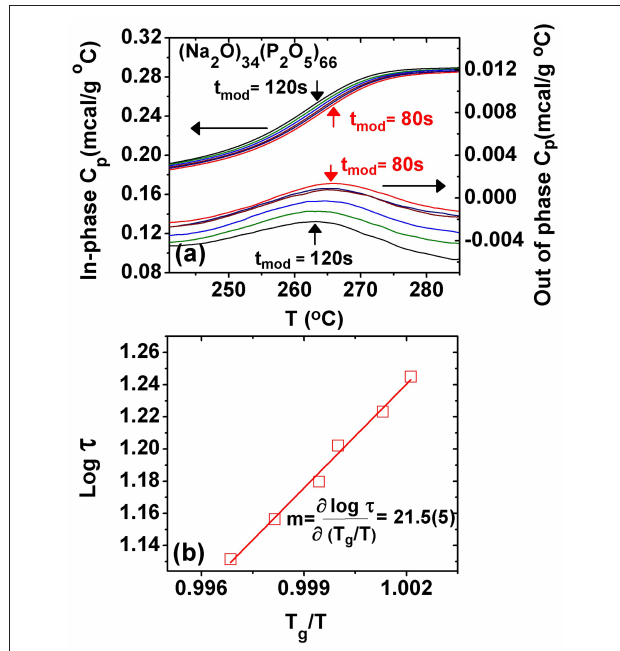
FIGURE 2 | (a) Observed variation of the in-phase C ip p and the out-of-phase C p op specific heat as a function of modulation frequency. Note that as the frequency increases, the peak in C p op shifts to higher temperatures as the glass must relax faster so ω τ = 1. (b) A plot of the enthalpic relaxation time τ as a function of T/T g displaying an Arrhenius variation, with a slope that fixes the fragility index m = 21.5(5). T g is determined from the inflection point of the C ip p at a modulation time period of